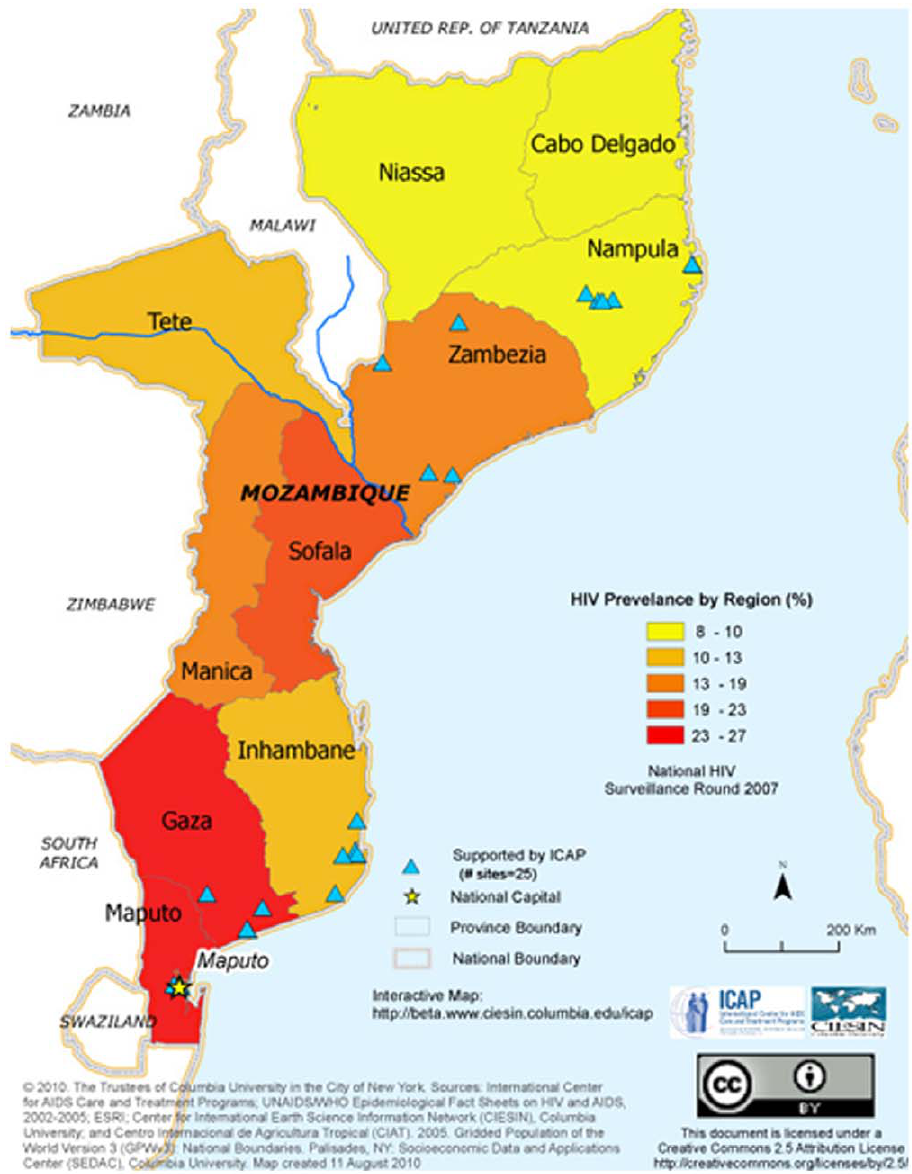
Figure 1. Geographic distribution of the 25 sites included in this analysis.